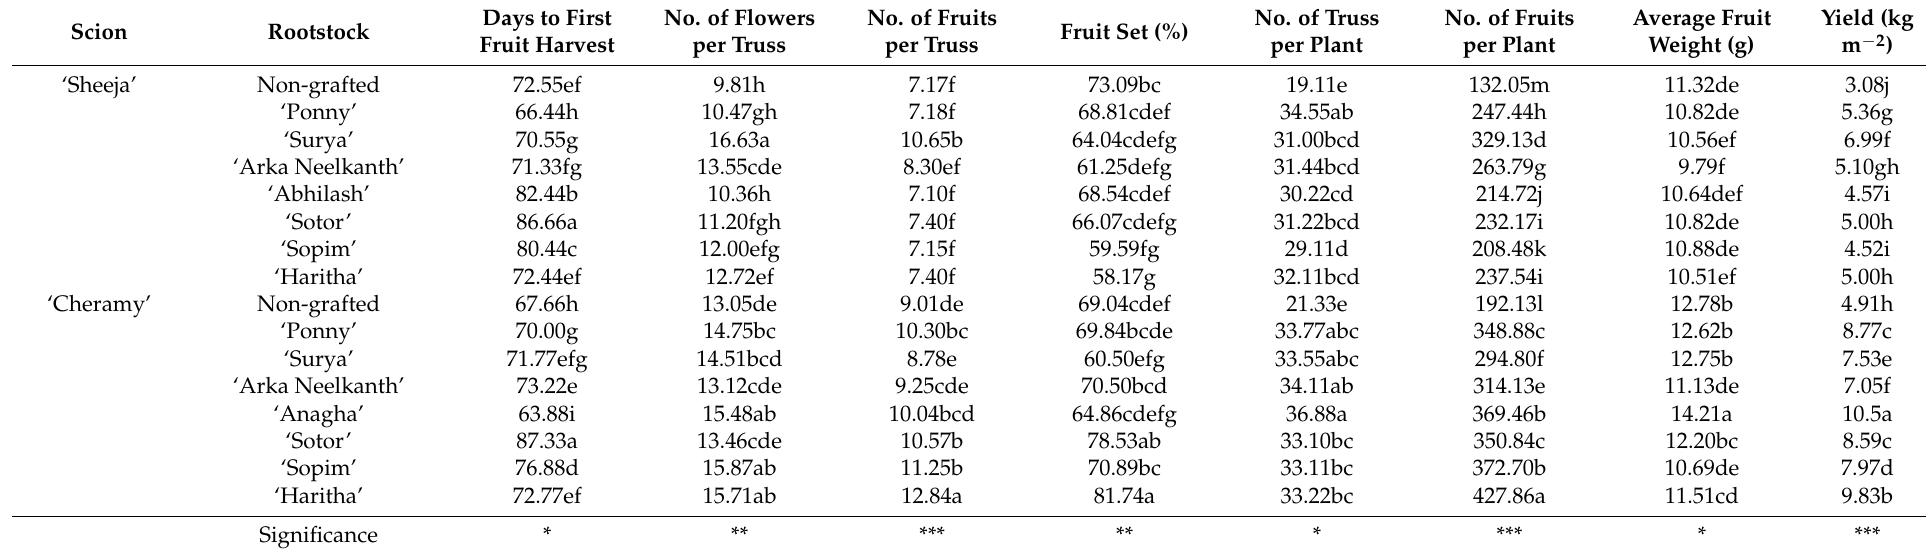
Table 5. Number of flowers and fruits per truss, number of truss and fruits per plant, average fruit weight, fruit yield pe plant per square meter in different graft combinations of cherry tomato.